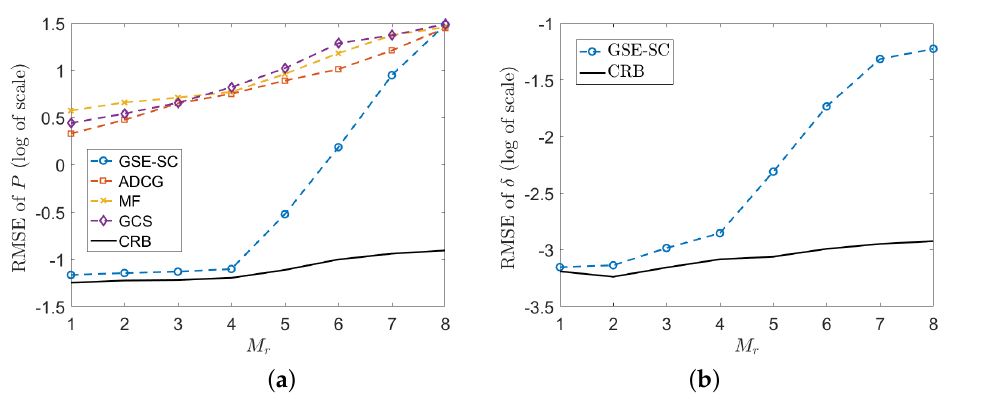
Figure 6. RMSEs of P and δ versus M r . ( a ) RMSE of P ; ( b ) RMSE of δ .